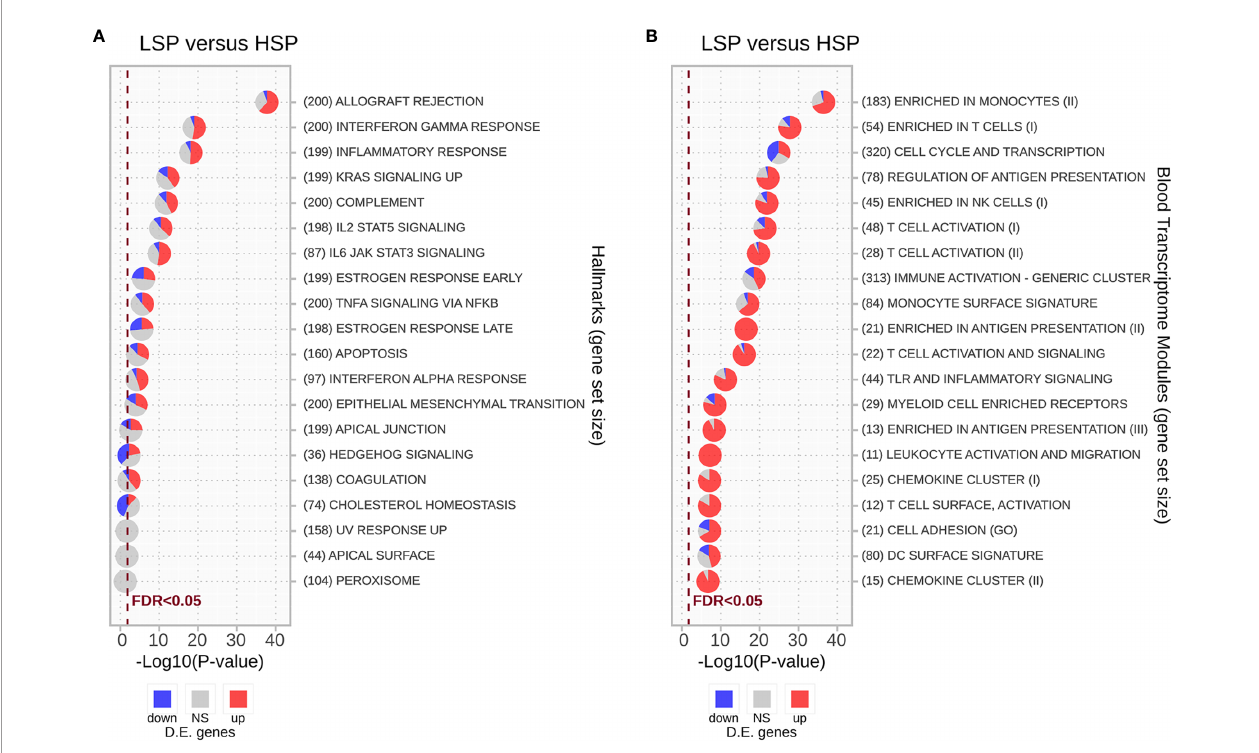
FIGURE 4 | Enrichment analysis for differentially expressed genes using the CERNO test. The CERNO test was applied to the differentially expressed genes using the hallmark gene sets (A) and blood transcriptome modules (BTMs) (B) . The modules are ordered according to the adjusted p-values and are considered non- signi fi cant based on a false discovery rate (FDR) of 0.05. The number of genes in each module is presented before the module names in brackets. The charts are colored based on the DE results: red for module genes upregulated in low steroid phenotype (LSP) and downregulated in high steroid phenotype (HSP), gray for module genes with no signi fi cant p-value, and blue for module genes down-regulated in LSP and upregulated in